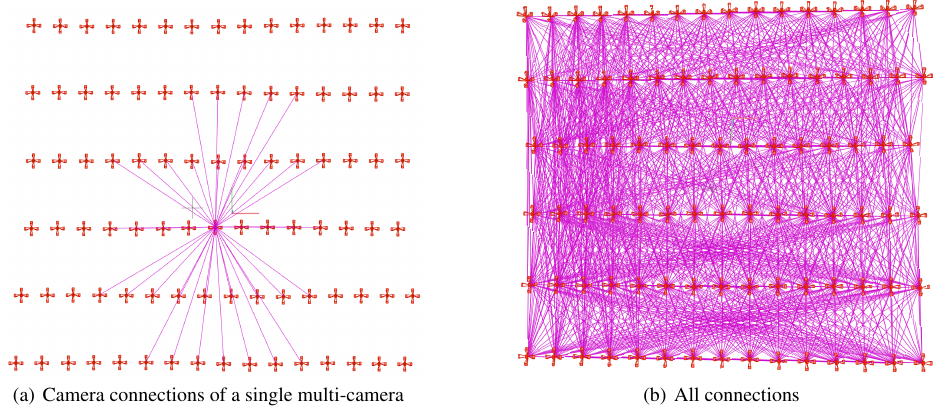
Figure 1. Leica CityMapper dataset. The two plots depict the overlap pattern of the images. In red are the camera poses, and in magenta are the image connections.